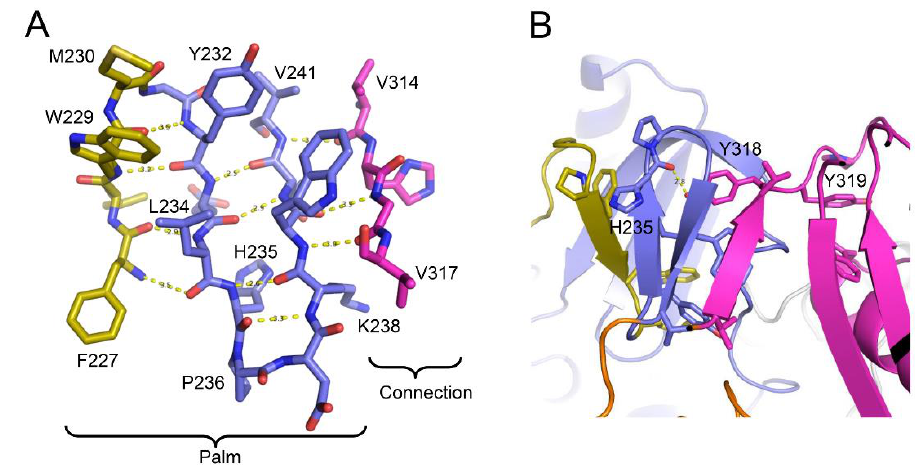
Figure 6. Formation of the palm:connection interface in p66 E . ( A ) β -sheet structure formed from palm loop residues (gold) and following palm domain residues 231–241 (blue), and residues 313–317 in the connection domain (magenta), that form the new palm:connection interface; ( B ) Formation of the β -sheet also creates a binding pocket for connection domain residue Tyr318, which also forms an H-bond with His235.